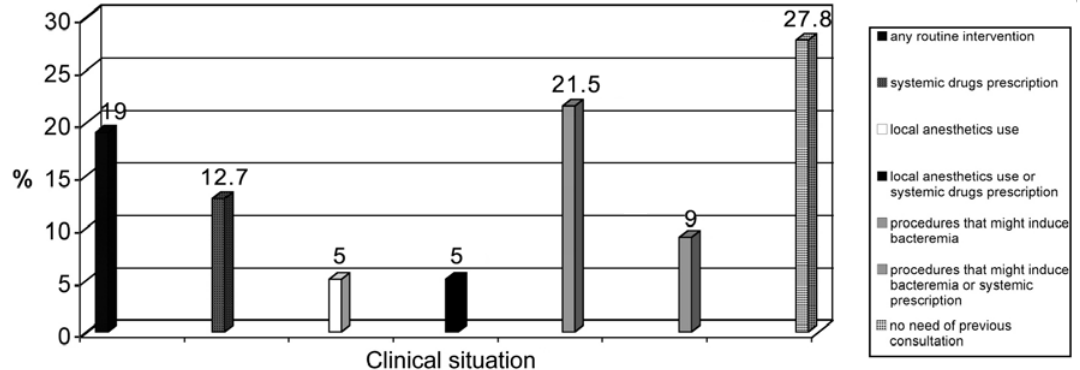
FIGURE 1- Clinical situations in which obstetricians (n=79) would like to be previously